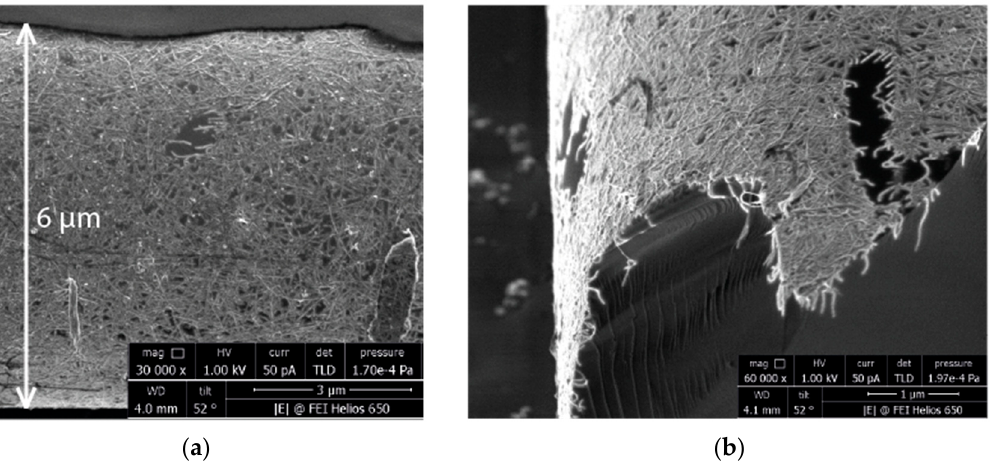
Figure 6. SEM images of SWCNTs thin film coating the tapered sensor waist: plan view ( a ) and cross-section ( b ).